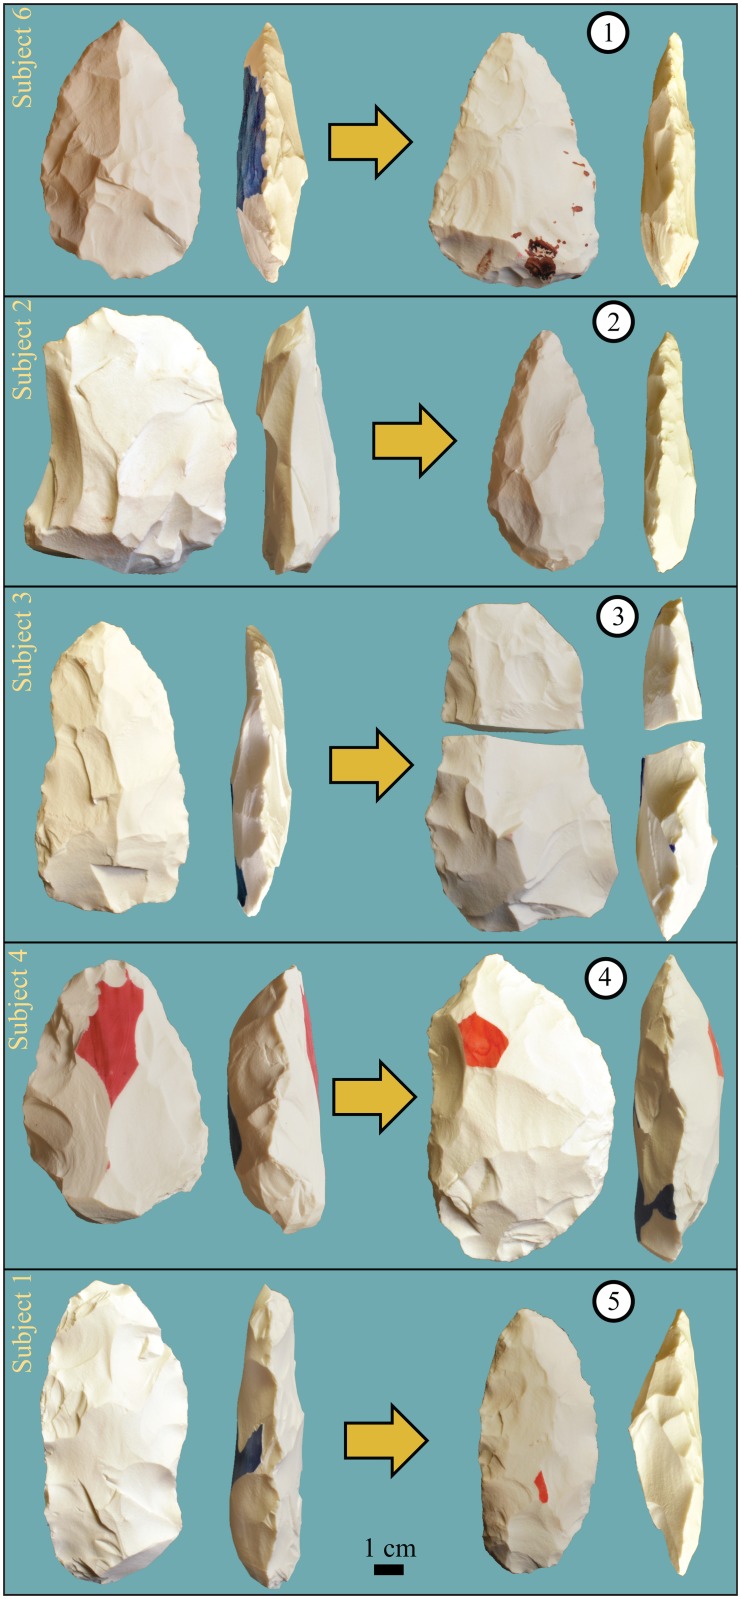
Handaxes produced for the first (left) and last (right) evaluations, ranked by T3 fMRI task performance (circled numbers).